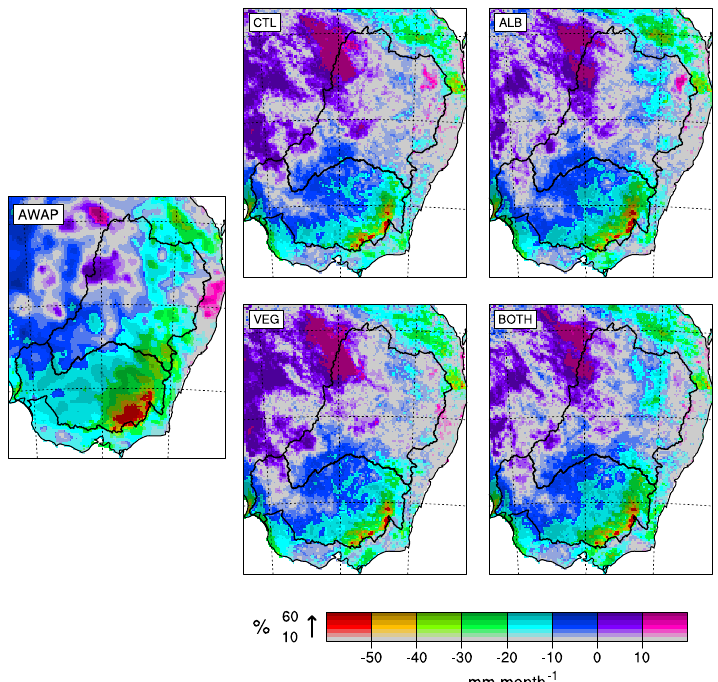
Figure 8. The precipitation change from 2005 (normal) to 2006 (drought) for each model simulation and observations. The hue of the colours gives the change in mmmonth − 1 , while the saturation/intensity gives the change in percentage terms. Grey areas have less than 10%